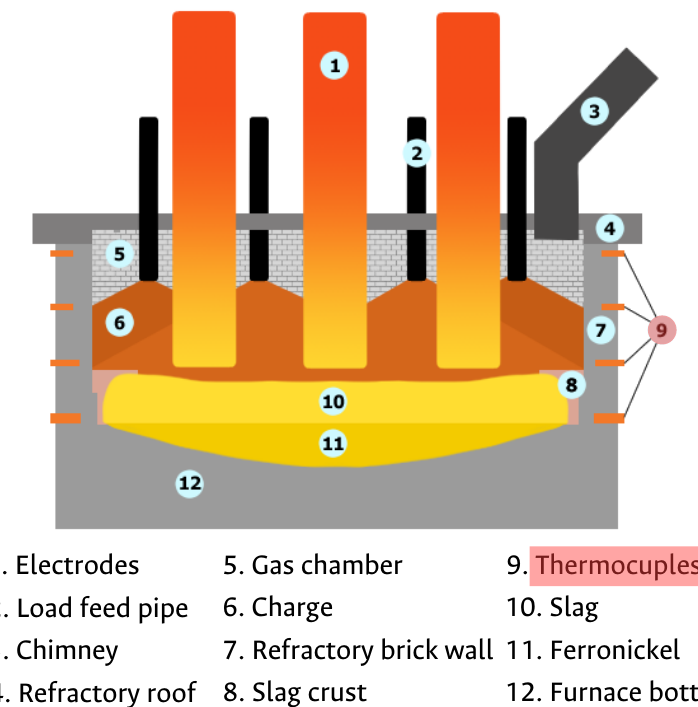
Figure 2. Electric arc furnace components